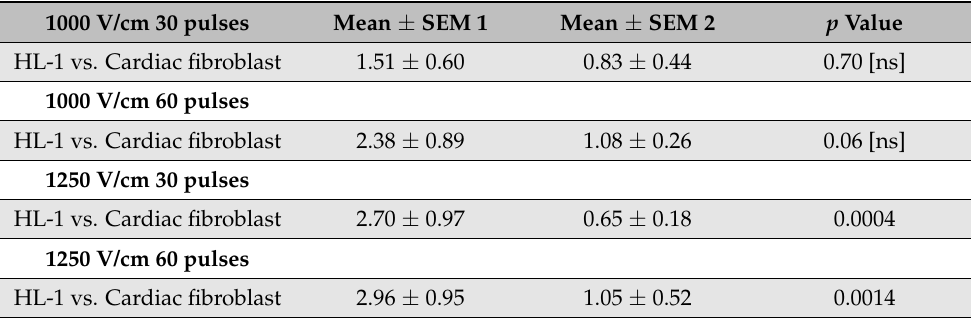
Table 2. Direct comparison of PI permeability between Hl-1 cardiomyocytes and cardiac fibroblasts at the 0.5-h time